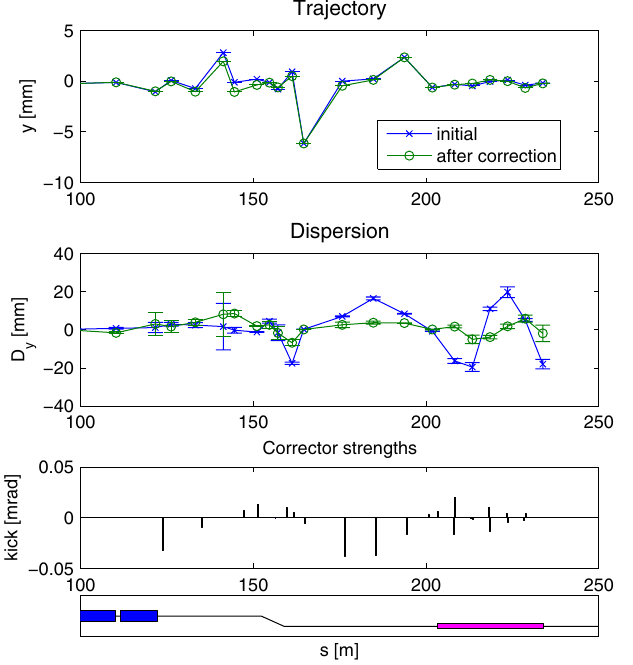
FIG. 4. (Color) Example of a vertical dispersion correction at